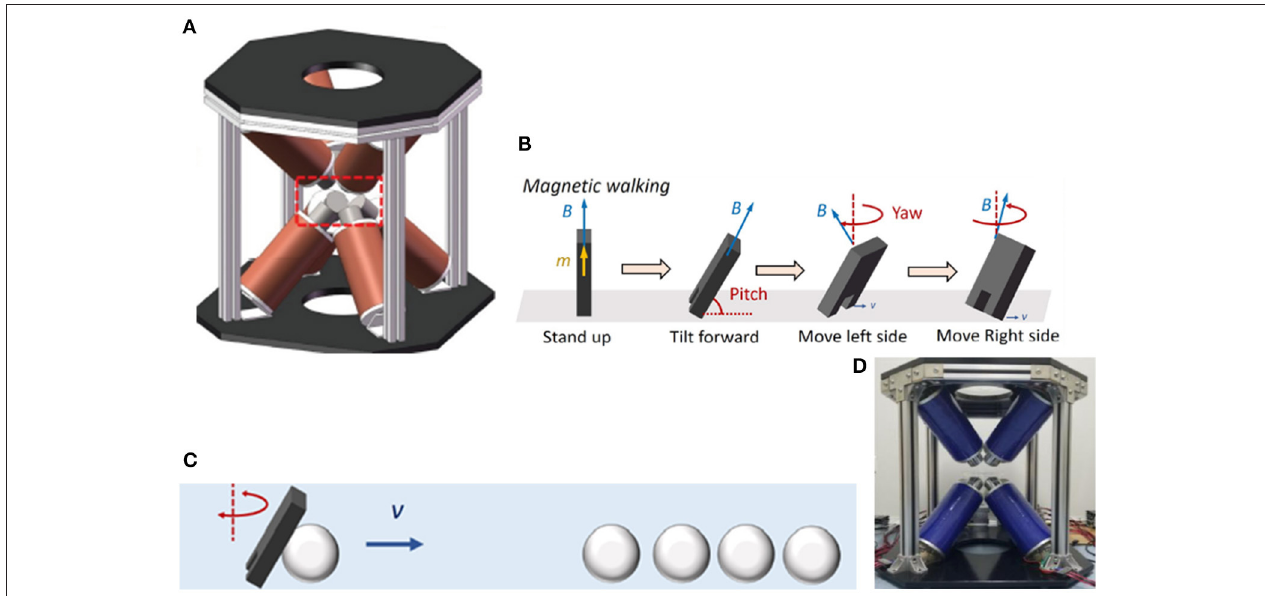
FIGURE 2 | (A) External electromagnetic system has 8 electromagnetic coils distributed diagonally to control a micro robot with two pseudopods to perform magnetic walking ( Li et al., 2020). (B) The process of magnetic walking of a micro-robot by alternately raising the left and right feet (Li et al., 2020) (C) Indirect pushing of non-magnetic microbeads ( Li et al., 2020) (D) Octupole magnetic system provides magnetic drive in rotating field and gradient field to ISMEs (Zheng et al.,